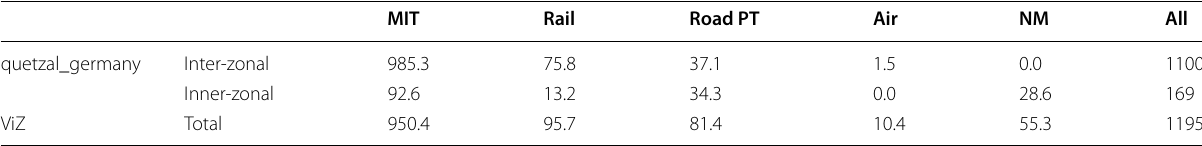
Table 4 Total traffic (billion pkm) by mode for ViZ and quetzal_germany results (the upper value shows modelled results, the lower value shows data generated from VP2030 and MiD2017) MIT Rail NM All